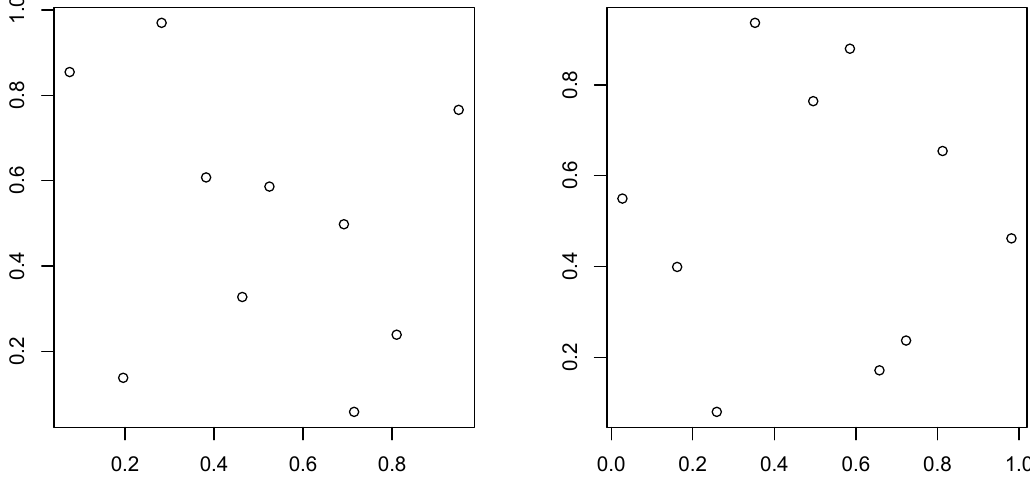
Figure 3: Two two-dimensional Latin hypercube designs created by the function maximinLHS